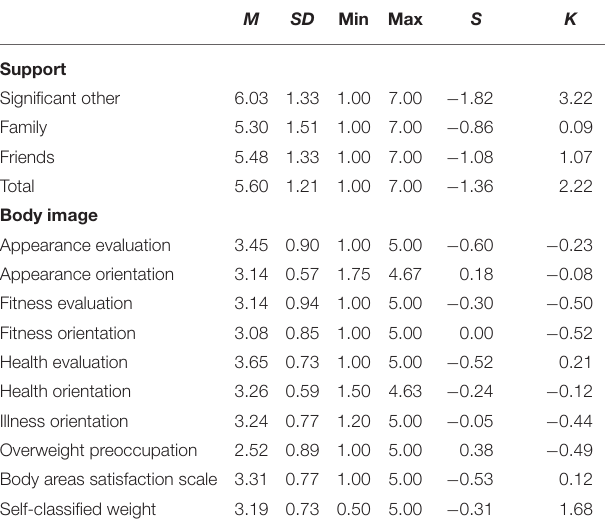
TABLE 2 | Descriptive statistics for variables in the study sample ( N =